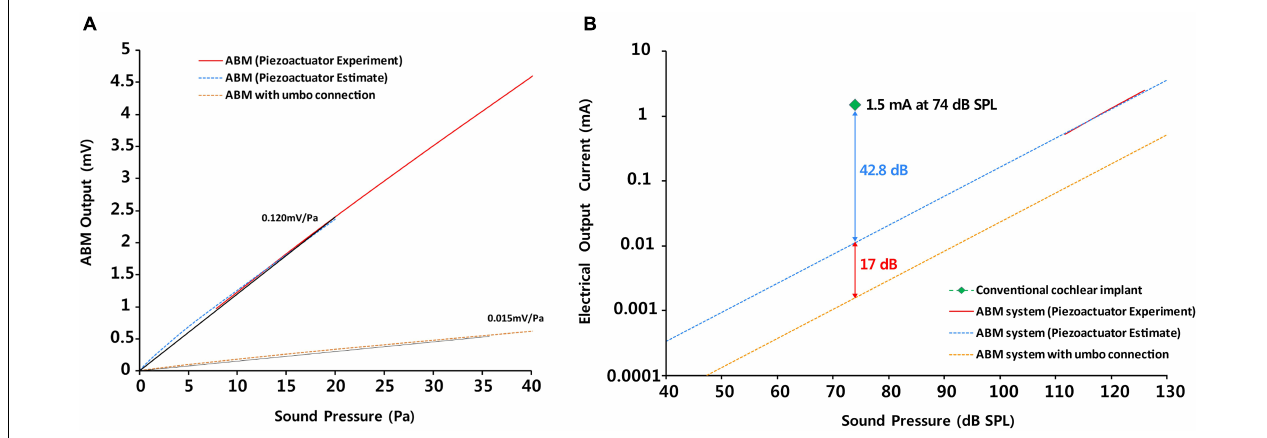
FIGURE 6 | The comparison of (A) the sensitivity as a sensor between ABM and ABM with umbo connection and (B) the efficacy between the conventional cochlear implant, ABM system, and ABM system with umbo